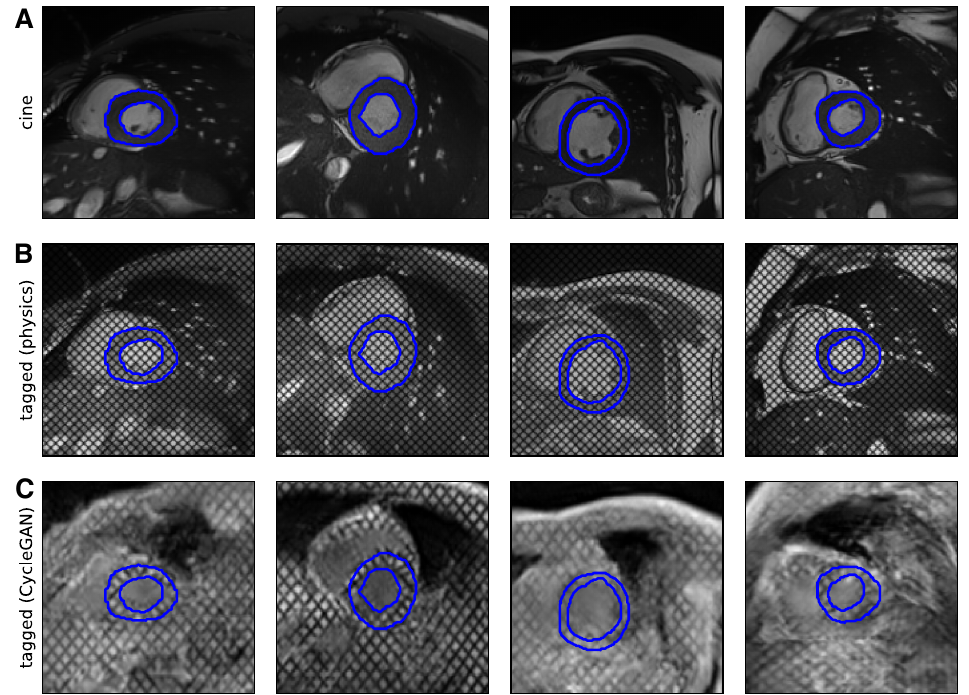
Figure 5. Examples of cine to tagged image transformation performed by ( B ) the physics-driven transformation and ( C ) the trained CycleGAN on ( A ) a set of labeled images from the ACDC dataset, completely disjoint from the dataset used to train the CycleGAN.